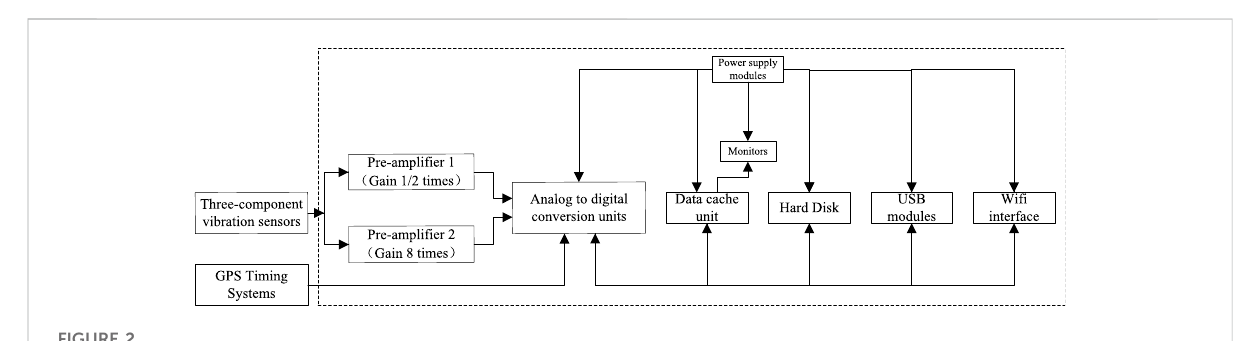
FIGURE 1 Distribution of ground monitoring stations in mining area.